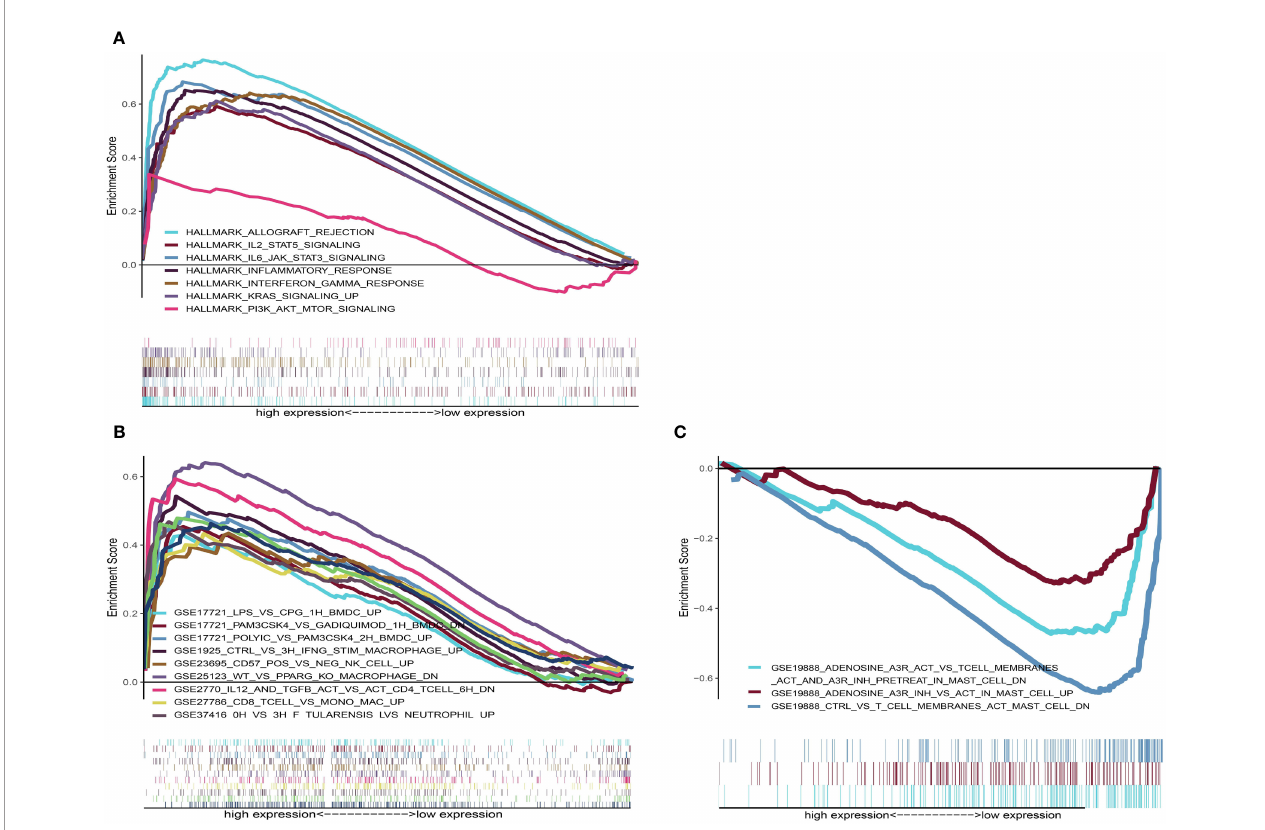
FIGURE 9 | GSEA analysis for patients with high-risk and low-risk. (A) The enriched gene sets in HALLMARK collection in high-risk group. Each line representing one particular gene set with unique color. Only gene sets with NOM p < 0.05 and FDR q < 0.25 were considered signi fi cant. Only several leading gene sets were displayed in the plot. (B) The enriched gene sets in C7 collection (the immunologic gene sets) in high-risk group. (C) Enriched gene sets in low-risk group of C7